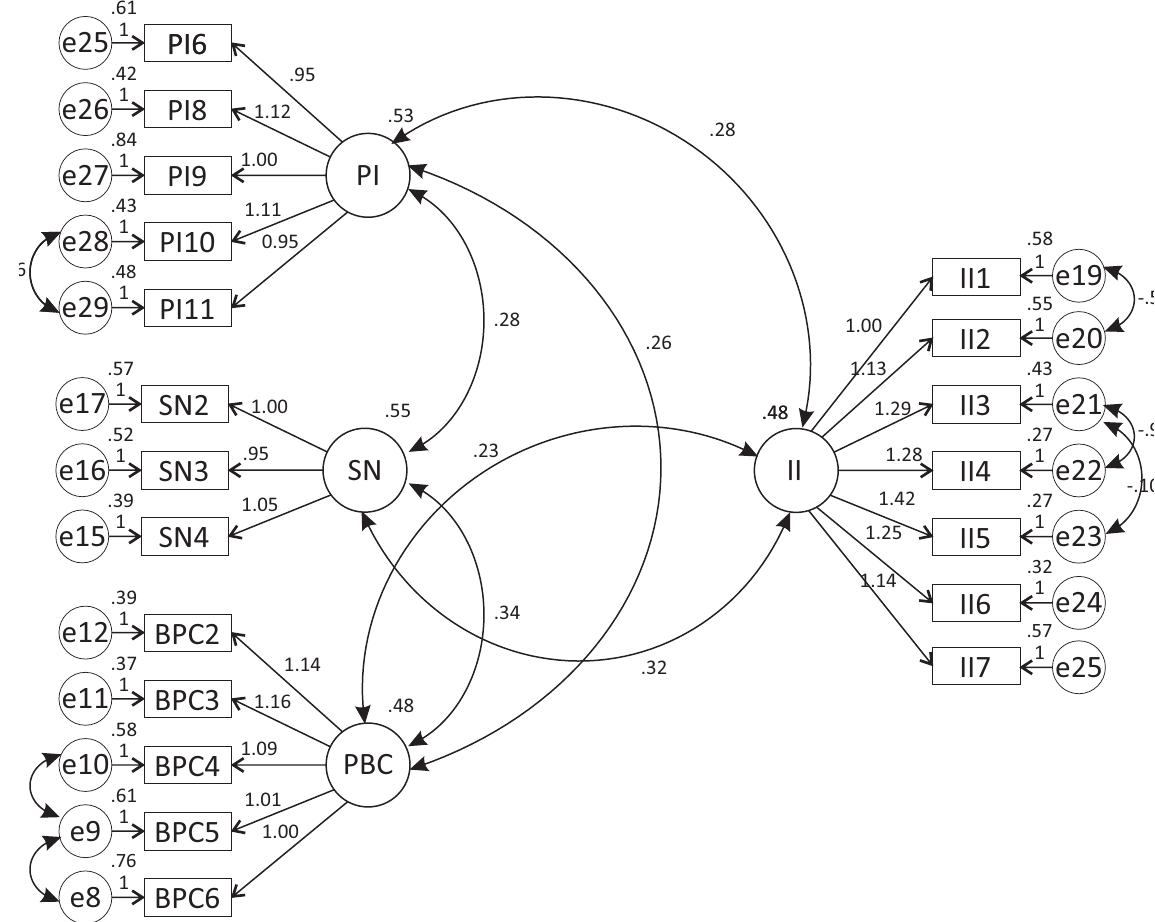
Figure 1. Measurement